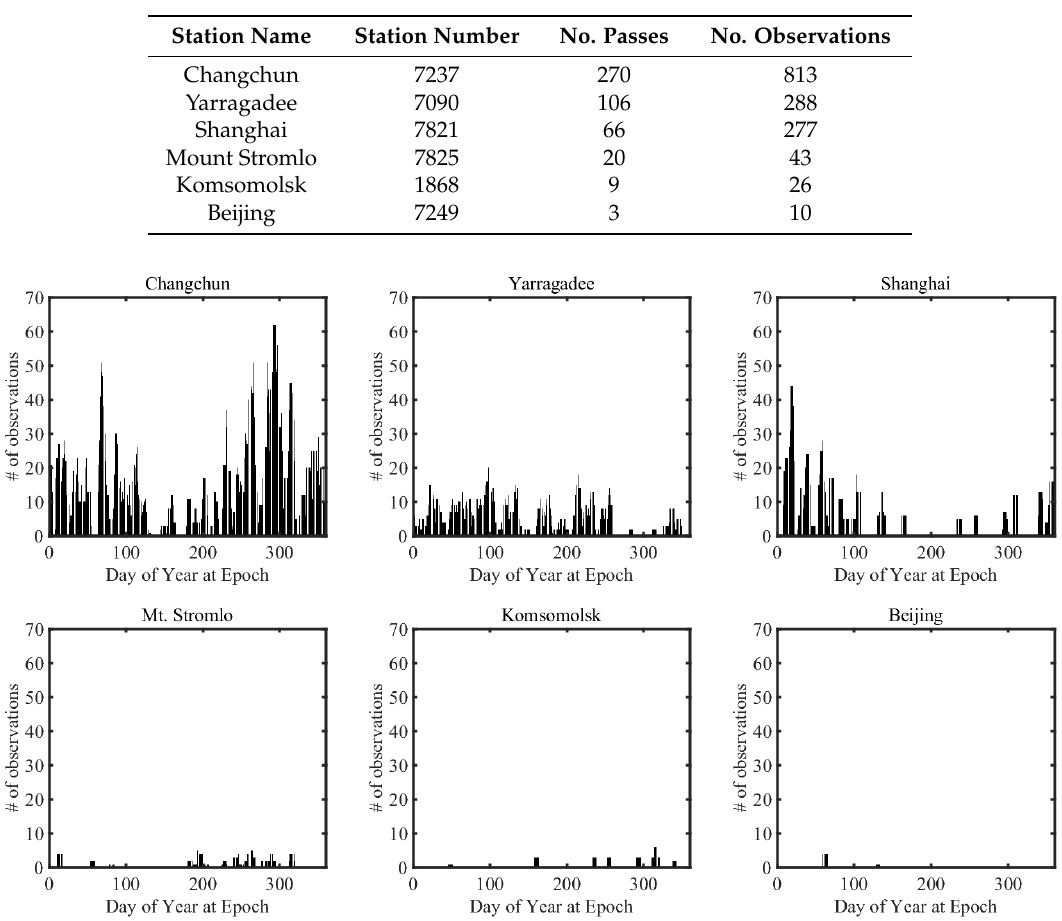
Figure 6. The number of Compass-G1 measurements in 2017.